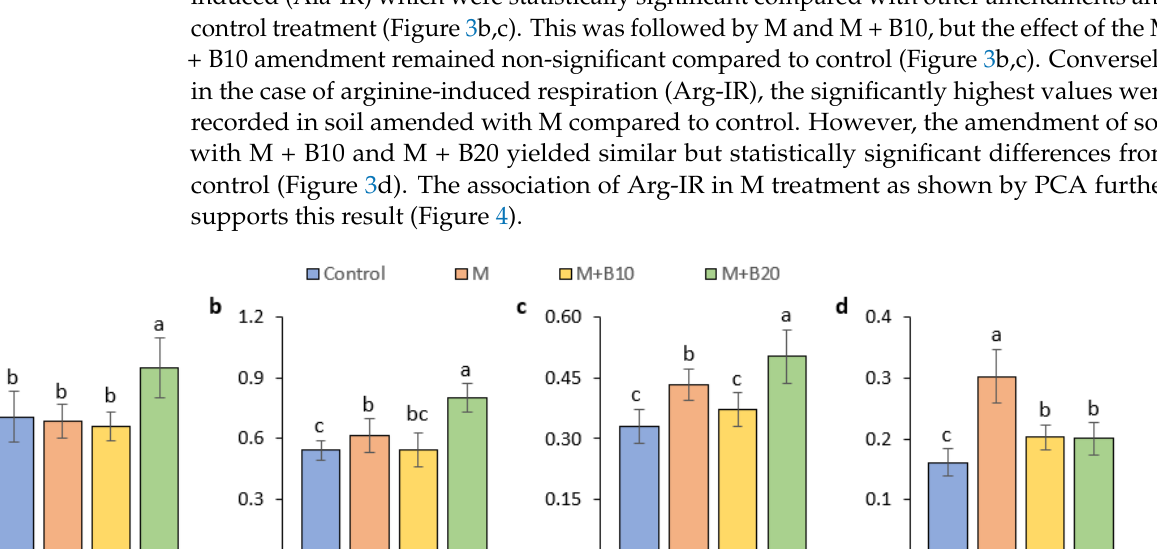
Figure 2. The effects of different amendments on: ( a ) dehydrogenase activity; ( b ) β -glucosidase ac- tivity; ( c ) phosphatase activity; and ( d ) N -acetyl- β - D -glucosaminidase. Different lowercase letters represent statistical difference at p = 0.05, ( n = 3).